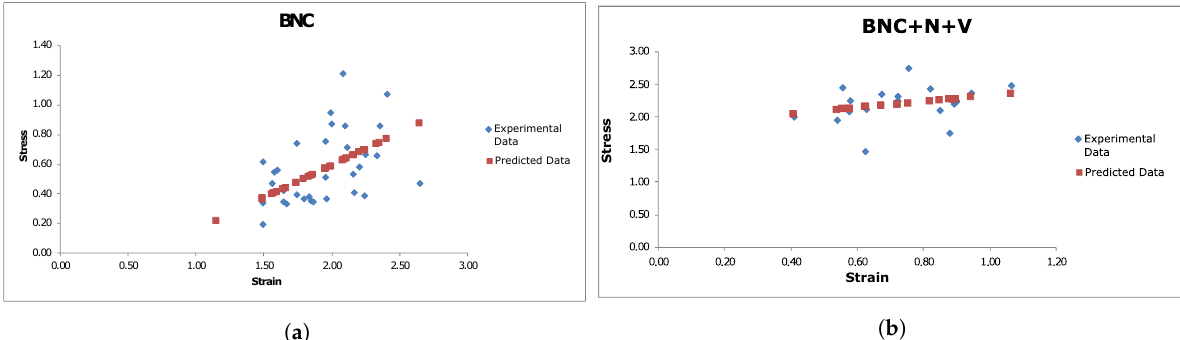
Figure 8. Linear regression for BNC ( a ) and BNC + N + V ( b ) samples for stress-strain relationship. Reprinted from [42].